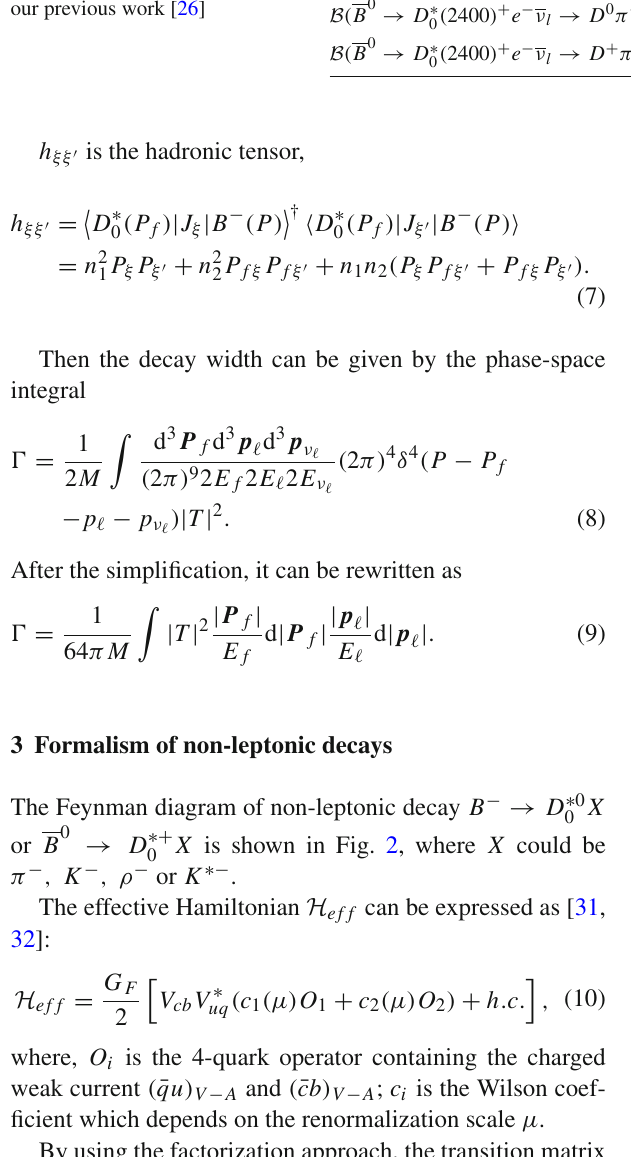
Table 2 The branching ratios( × 10 − 3 ) of cascade decays to D π (with l = e ). The branching ratio ( 2400 ) → D π) is from B ( D ∗ 0